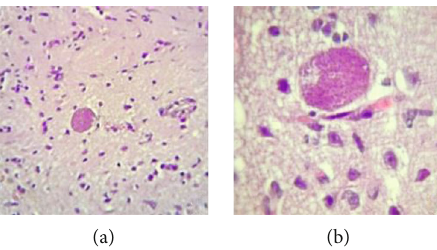
Figure 4: Toxoplasma cyst formation in mouse brains in group 3 (H&E staining): (a) 40x and (b)